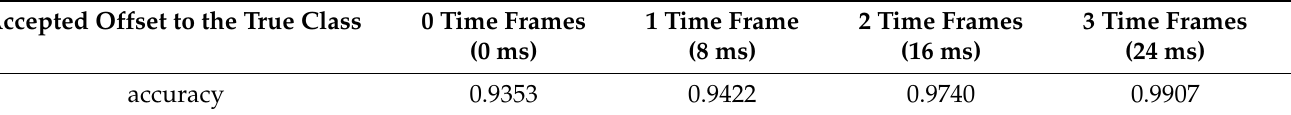
Table 2. The accuracy of an unseen subject when temporal uncertainty at transitions is taken into